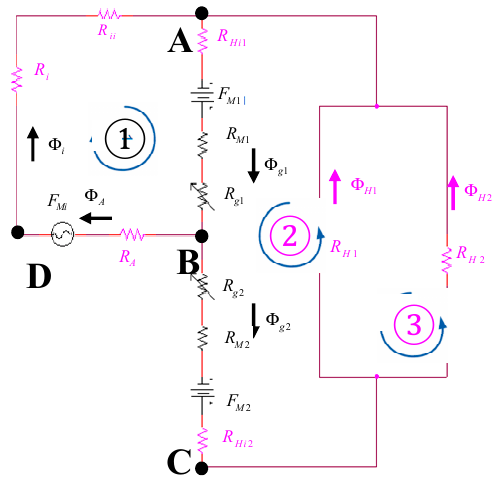
Figure 1. The equivalent circuit of the electromagnetic part.